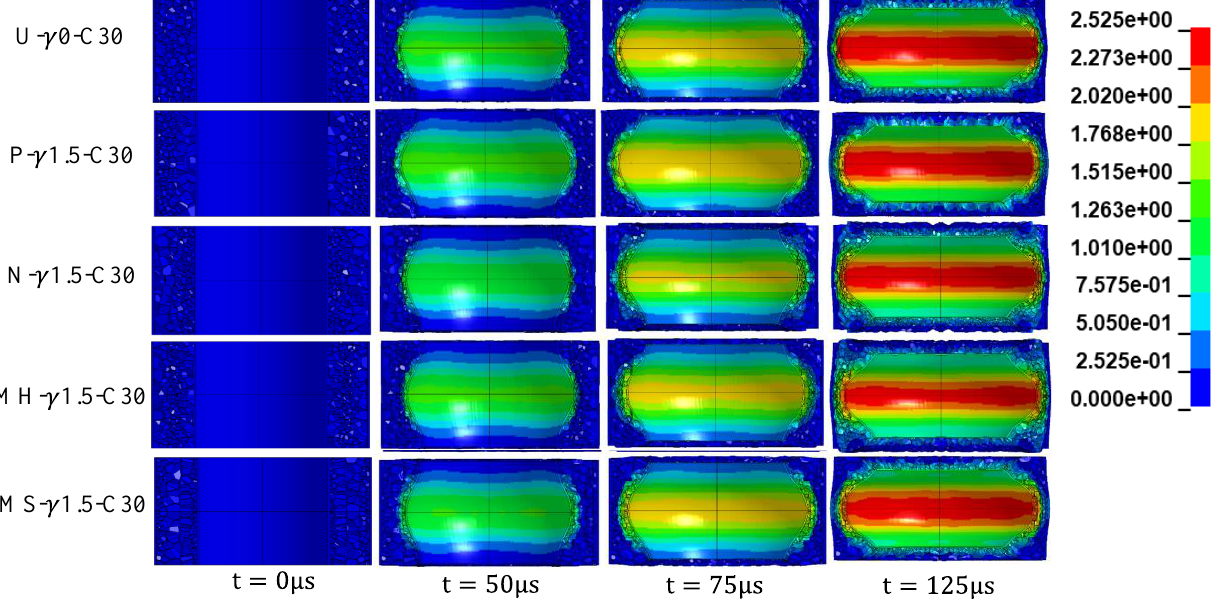
Figure 10. Cloud diagram of the deformation process of the foamed aluminum sandwich tube.